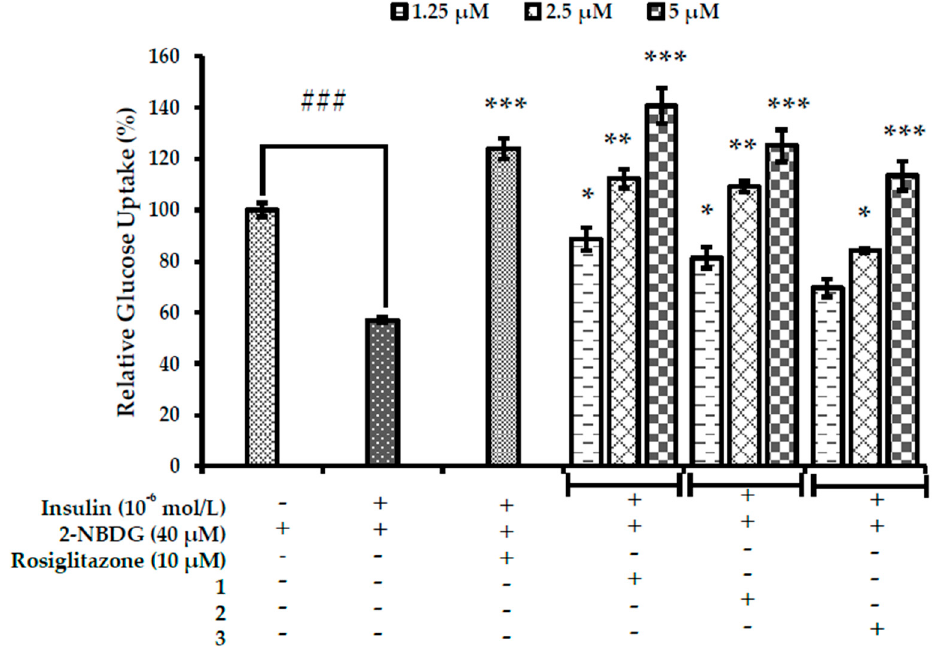
Figure 7. Effects of 1 – 3 on insulin stimulated glucose uptake in insulin-resistant HepG2 cells as measured by 2-[ N -(7-nitrobenz-2-oxa-1,3-diazol-4-yl) amino]-2-deoxyglucose (2-NBDG) method. Data shown represent means ± standard deviation of triplicate experiments. ### p < 0.001 indicates significant differences from the control group; * p < 0.05, ** p < 0.01 and *** p < 0.001 indicate significant differences from the 10 − 6 M insulin-treated control group.